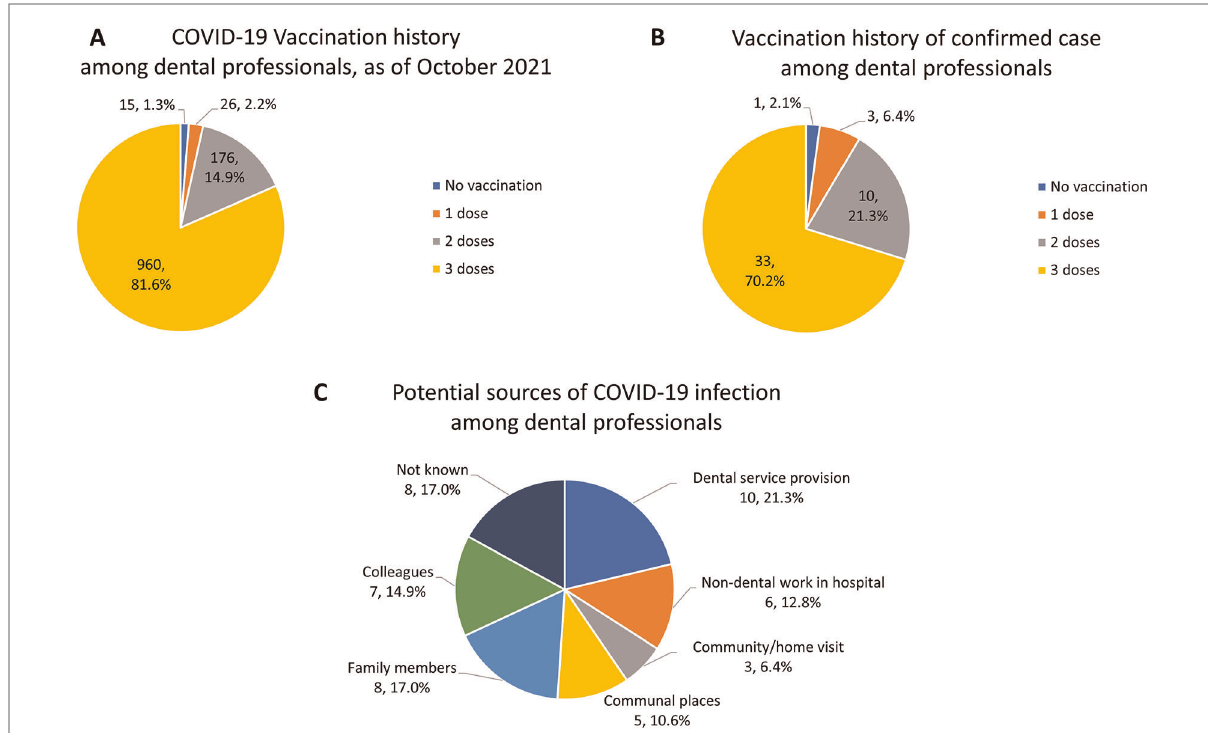
FIGURE 4 Vaccine taken up by the respondents ( A ) and by the COVID-19 con fi rmed case ( B ). Potential sources of COVID-19 infection among dental personnel ( C ) ( N , %). As of October